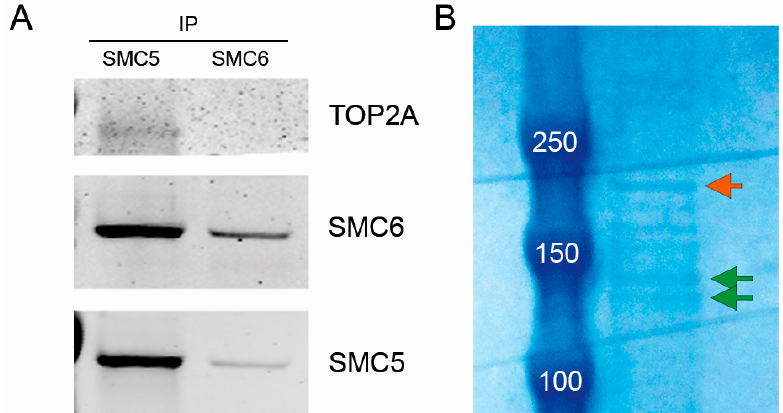
Figure 6. The SMC5/6 complex physically interacts with TOP2A. ( A ) Immunoprecipitations (IPs) and Western blot analysis of SMC5 and SMC6. Both SMC5 and SMC6 co-immunoprecipitated with each other. Additionally, TOP2A co-immunoprecipitated with SMC5; ( B ) For IP followed by mass spectrometry, Abcam rabbit anti-SMC6 was used. SMC6-IP material was loaded on a 4%–12% bis-tris gradient gel and stained with coomassie blue. Arrows indicate the bands that were isolated for mass spectrometry analysis (green: potential SMC5/6 proteins; orange: potential TOP2A protein).